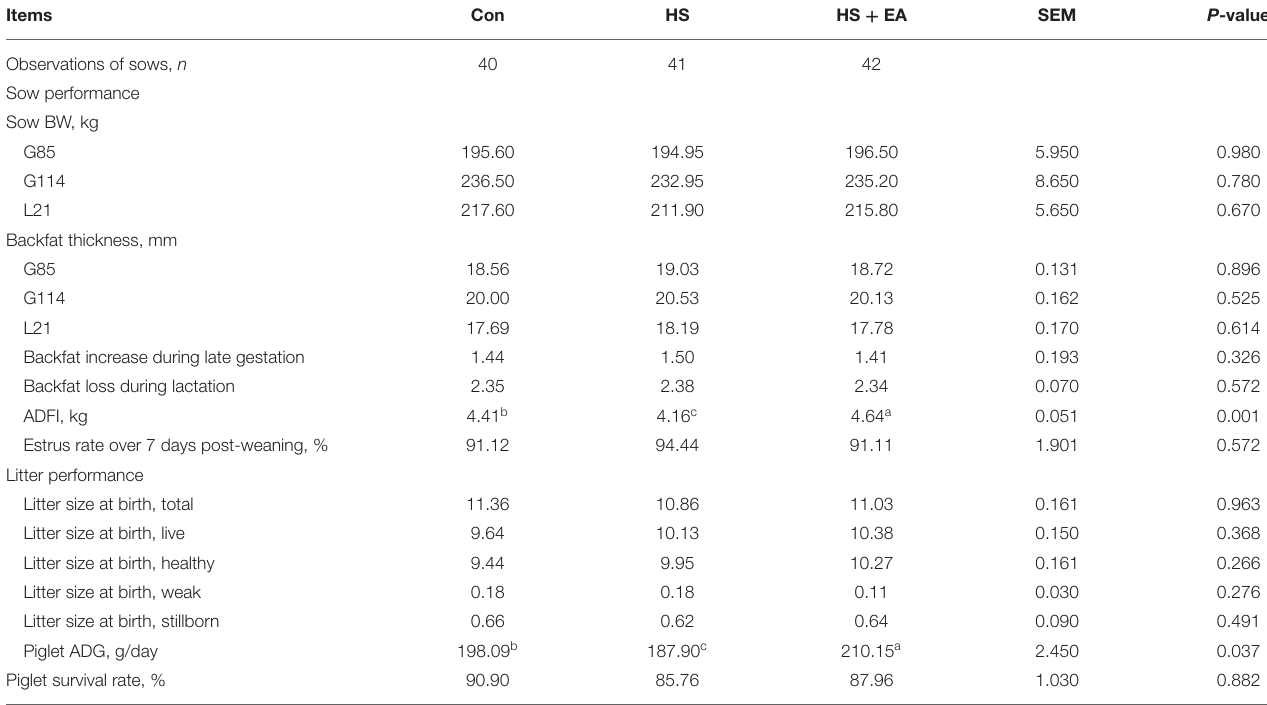
TABLE 2 | Effects of dietary supplementation with EA on lactation performance of sows.